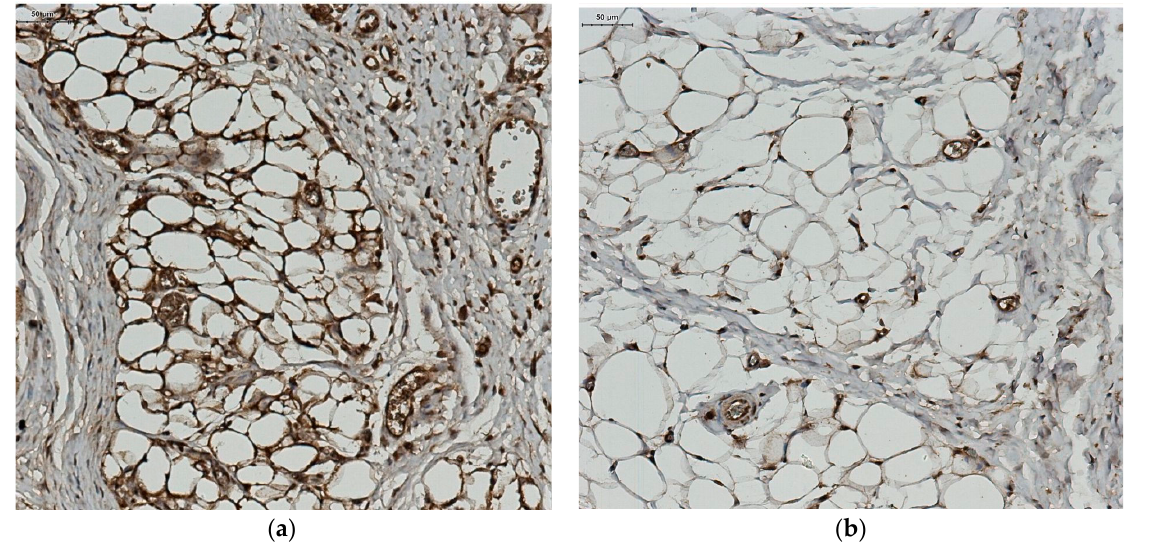
Figure 4. AdipoR1 immunoexpression ( a ) control group. AdipoR1—intense immunoexpression; ( b ) obese patient—AdipoR1 reduced immunoexpression.